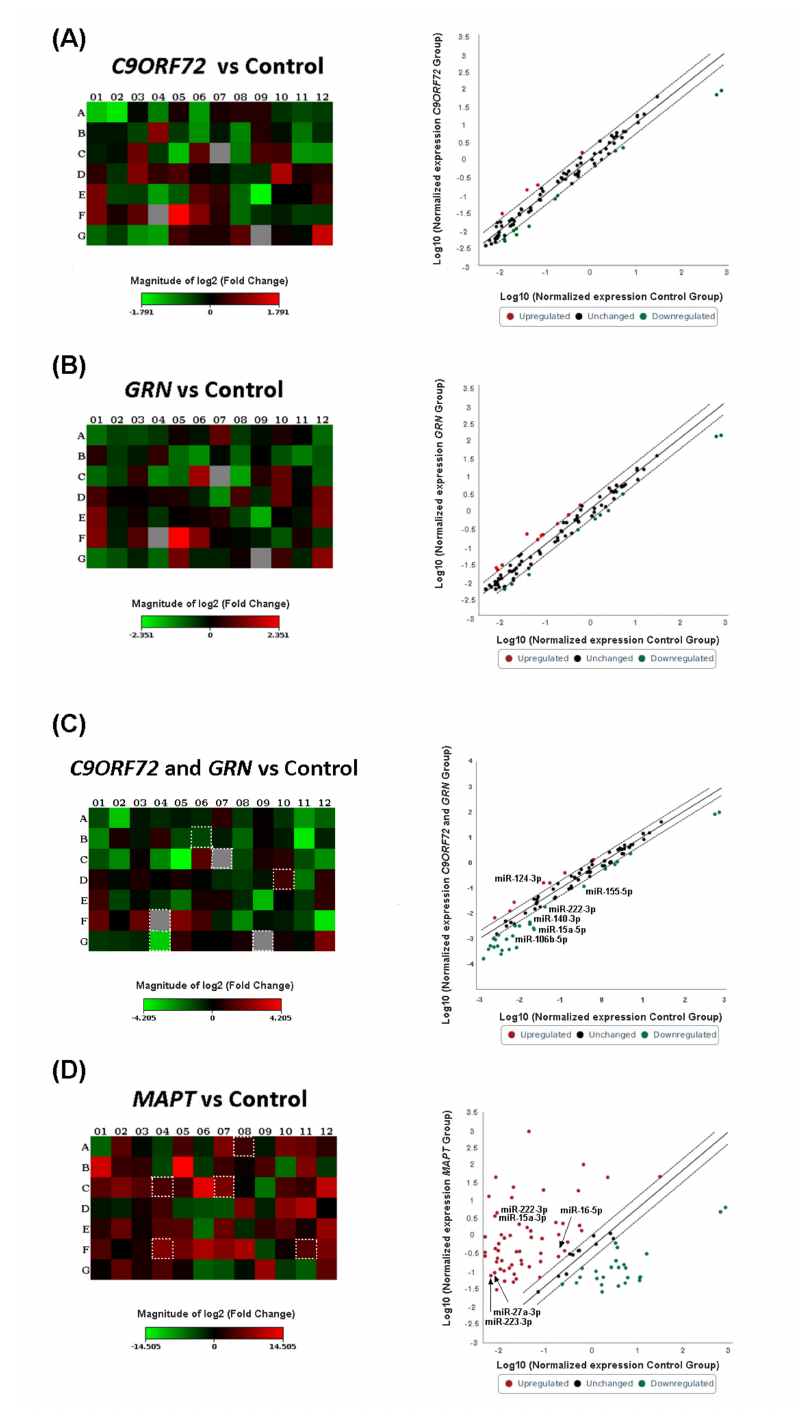
Figure 2. Heat map and scatter plot of miRNA profiling for FTD patients with C9ORF72 expansion ( A ); GRN mutation ( B ); GRN + C9ORF72 grouped mutation ( C ); MAPT mutation ( D ); versus control group. Heat Maps: FTD C9ORF72 expansion carriers ( A ); GRN mutation carriers ( B ); GRN + C9ORF72 grouped mutation ( C ); MAPT mutation carriers ( D ). Each square represents one of the 84 miRNAs in the array. Squares corresponding to the miRNAs described in the text are highlighted. Green indicates downregulation, red upregulation. Each scatter plot compares the normalized expression